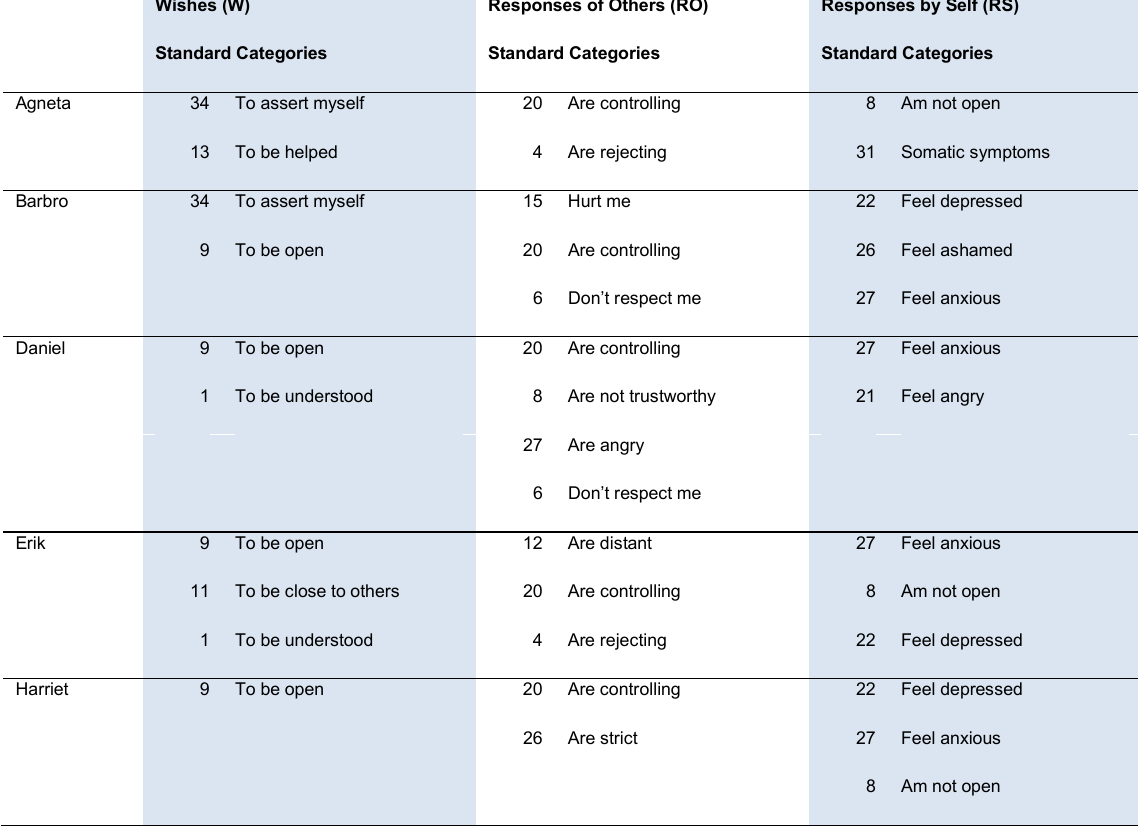
Table 3: Individual CCRT of most frequently occurring standard categories of the 5 clients components; W, RO and RS (Standard Categories with numberings (NO.) and designations) Wishes